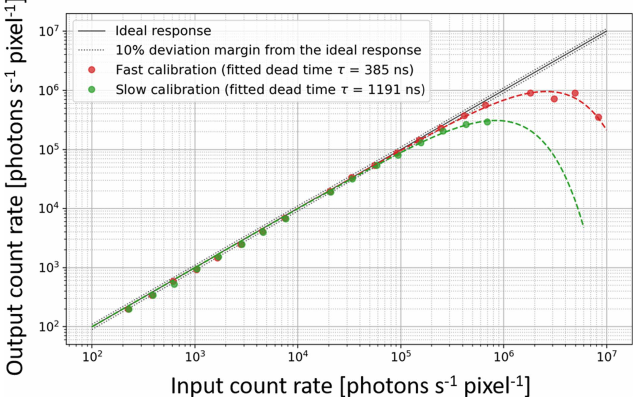
Figure 11 Count-rate linearity of the CirPAD measured for two different shaping times of the analogue front-end (FAST and SLOW).